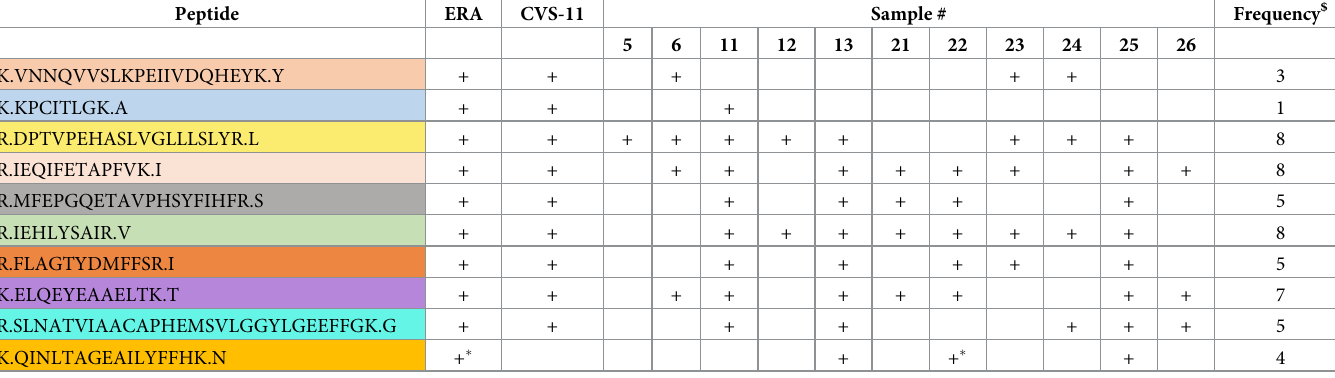
Table 2. Based on the amino acid sequence information identified by MS/MS, list of ten peptides and frequency of detection is tabulated.